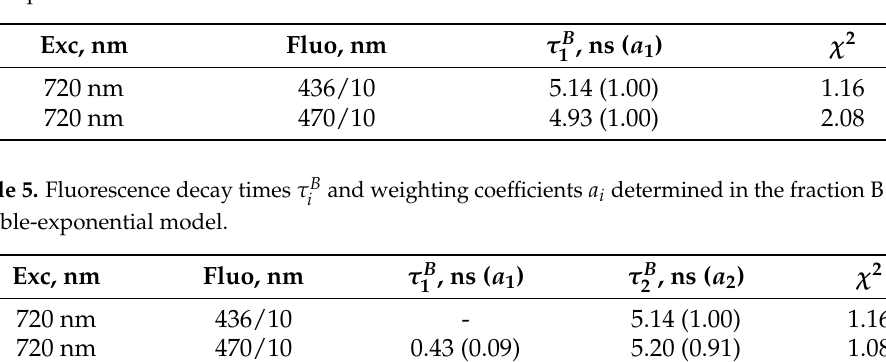
and weighting coefficients a i determined in the fraction B using i